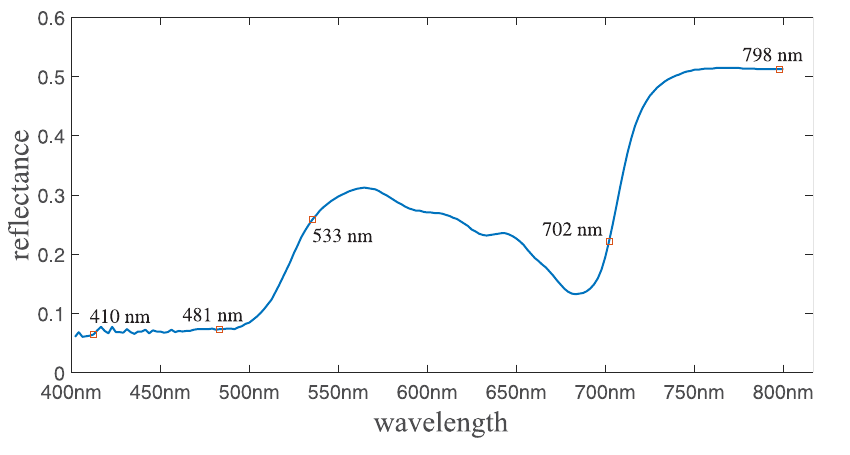
Fig 6. Selection of characteristic bands of SPA in the canopy layer of japonica rice.